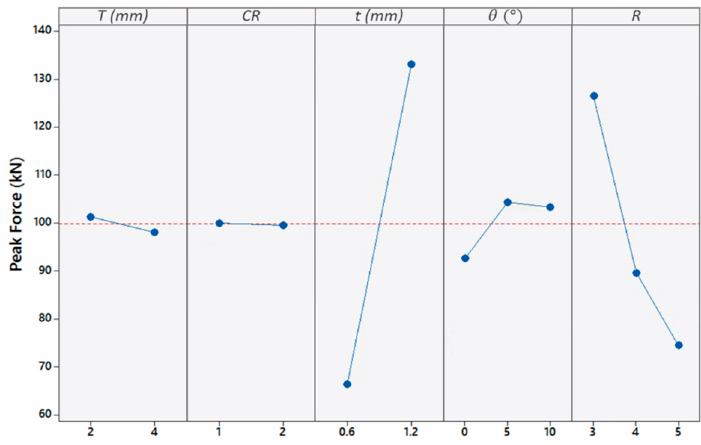
Figure 16. Influence of geometrical parameters on Peak Force.